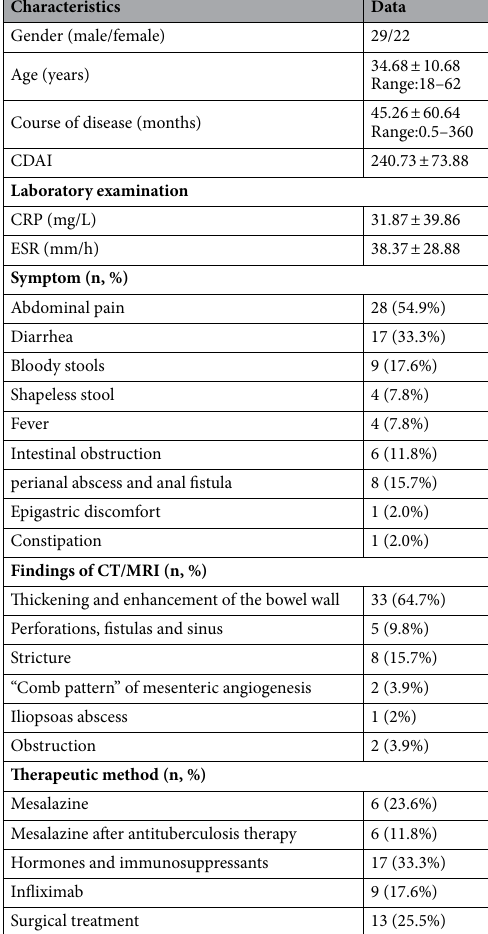
Table 1. Demographic and clinical data of 51 cases.